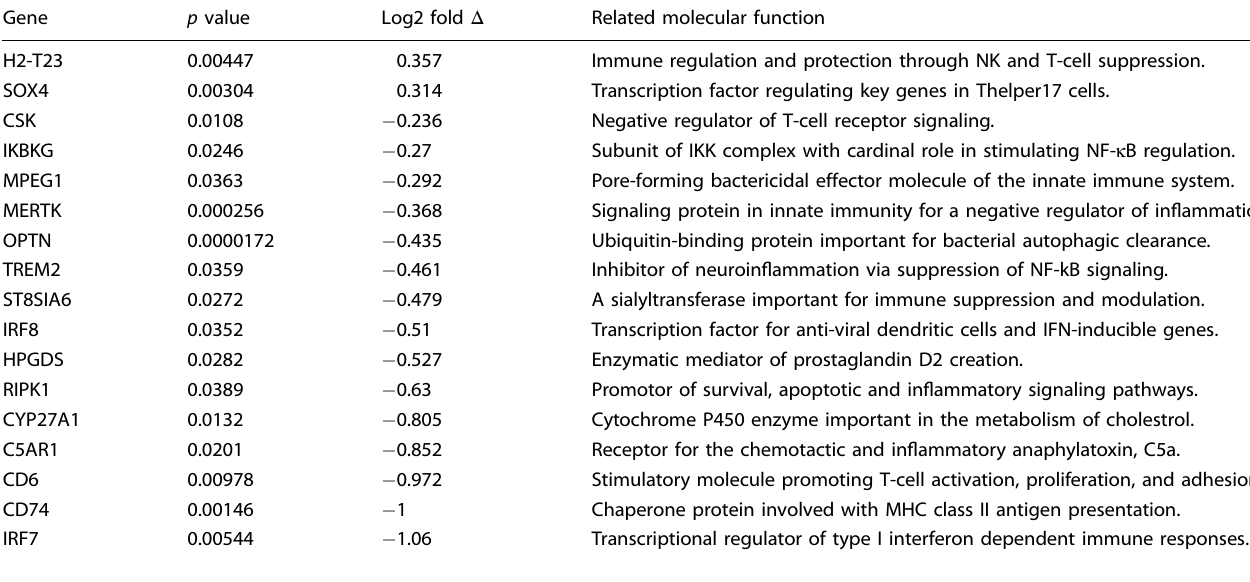
Table 4. Summary of signi fi cantly altered gene expressions by space fl ight related to immune function and in fl ammation.